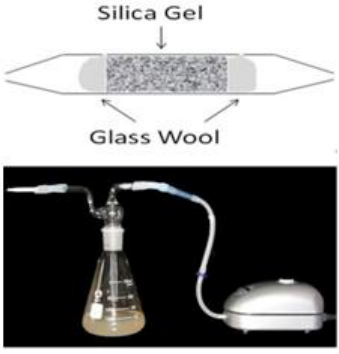
Figure 1. The chemo-trapping for volatile arsenicals. Silica gel (0.4-mm diameter) was steeped with 10% AgNO 3 solution ( w / v ) overnight, and dried at 70 ◦ C; oxygen was supplied with an adjustable air pump for the cell